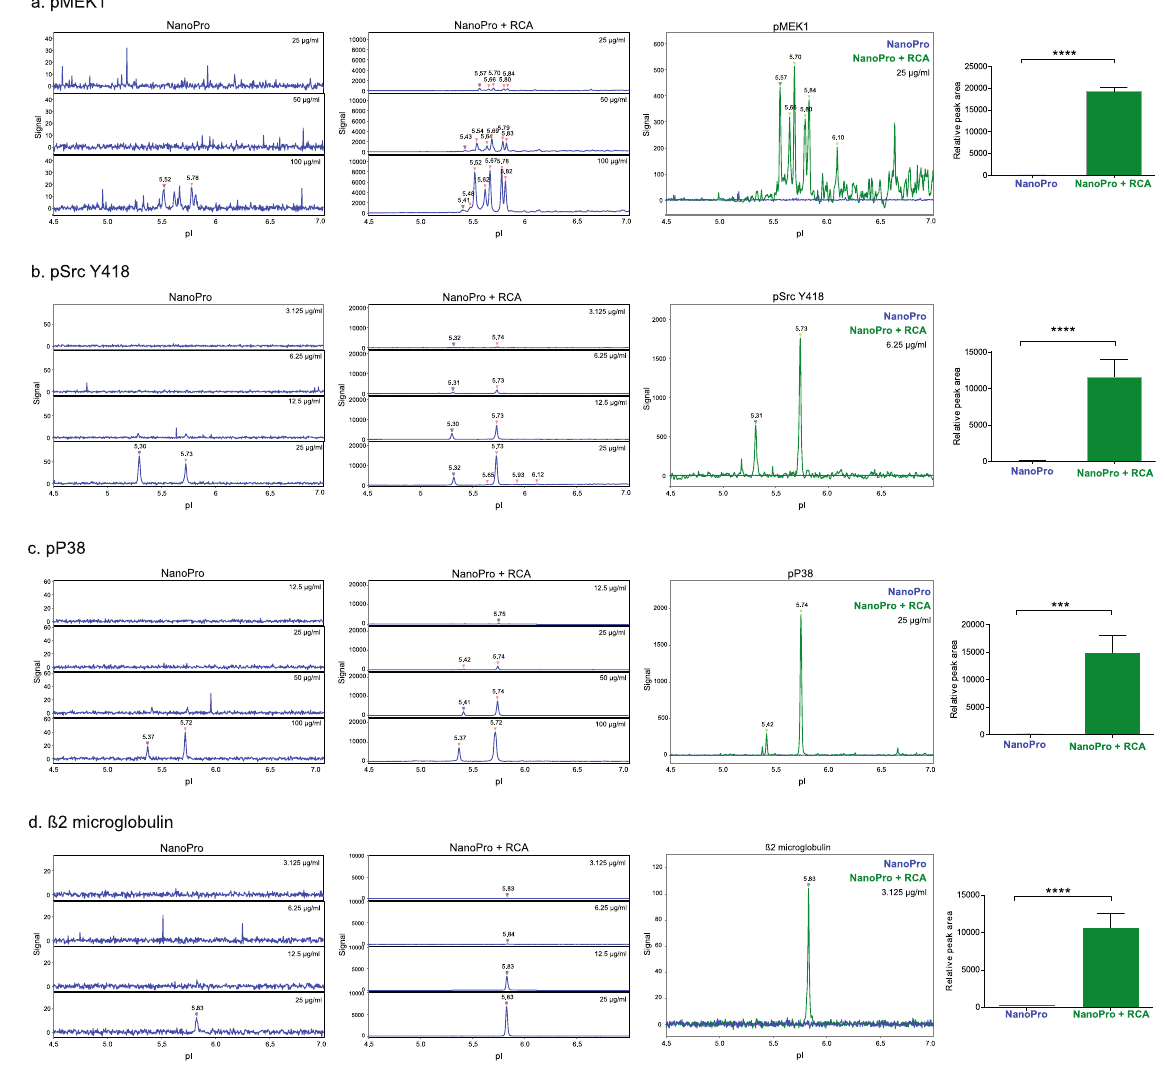
Figure 3. Detection of VEGFA-induced signal transducers. ( a–d ) Lysate of HUVECs treated with VEGFA and analyzed for pMEK1 ( a ), pSrc Y418 ( b ), pP38 ( c ), ß2 microglobulin ( d ) were detected with standard NanoPro assays (left panel) or NanoPro + RCA (middle panel). Detailed overlay graphs of protein detection with standard NanoPro assay (blue) and NanoPro + RCA (green) are shown in the right panel. Quantifications were done from three biological replicates (n = 3) with 4 technical replicates in each sample. Statistical significances were calculated using Student’s unpaired t-tests. p < 0.05 was considered statistically significant. *** p < 0.001 and **** p < 0.0001. Error bars in the graph represent mean ±